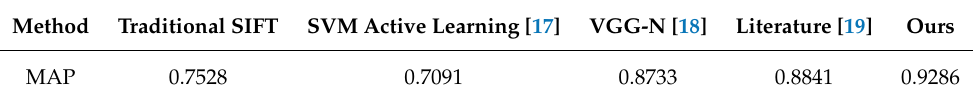
Table 2. The MAP of different methods on data set corel5k.